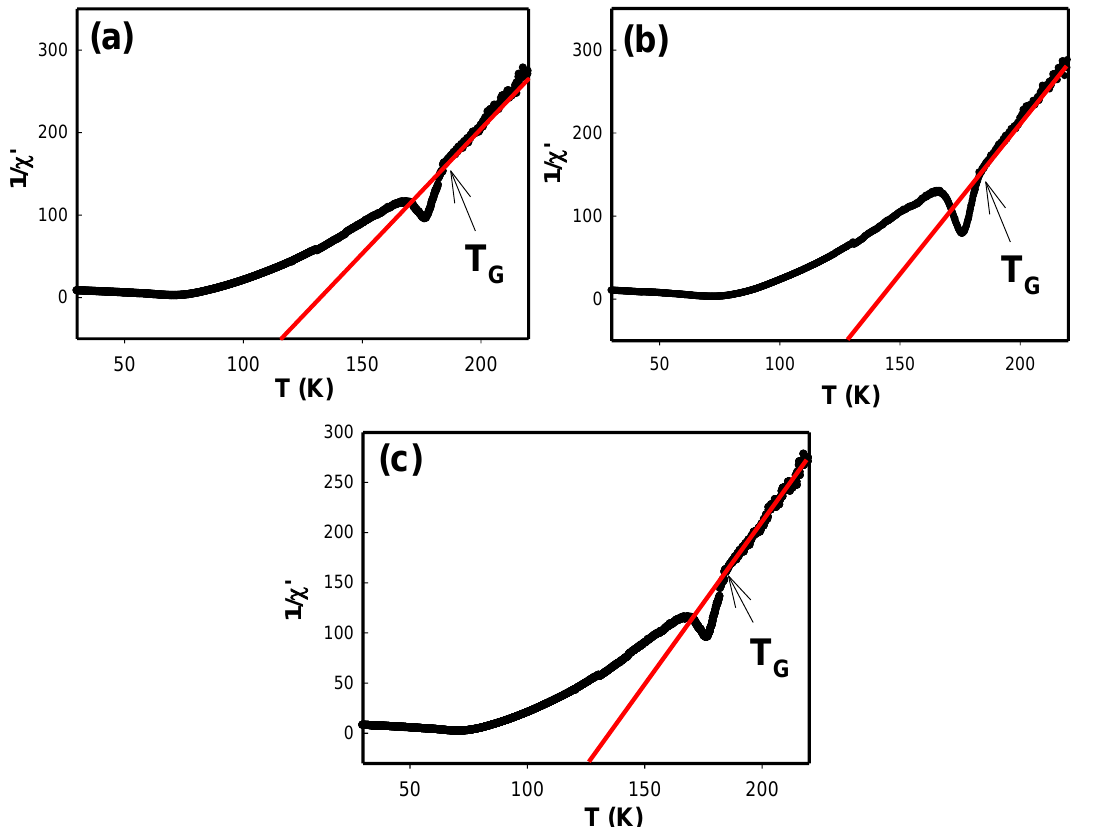
Figure 7 . Temperature dependence of inverse susceptibility spectra of Nd 1−x Bi x MnO 3 ( a ) x = 0, ( b ) x = Figure 7. Temperature dependence of inverse susceptibility spectra of Nd 1 − x Bi x MnO 3 ( a ) x = 0, 0.25 and ( c ) x = 0.5. ( b ) x = 0.25 and ( c ) x = Table 3. Parameters obtained from AC magnetic susceptibility studies of Nd 1−x Bi x MnO 3 samples.